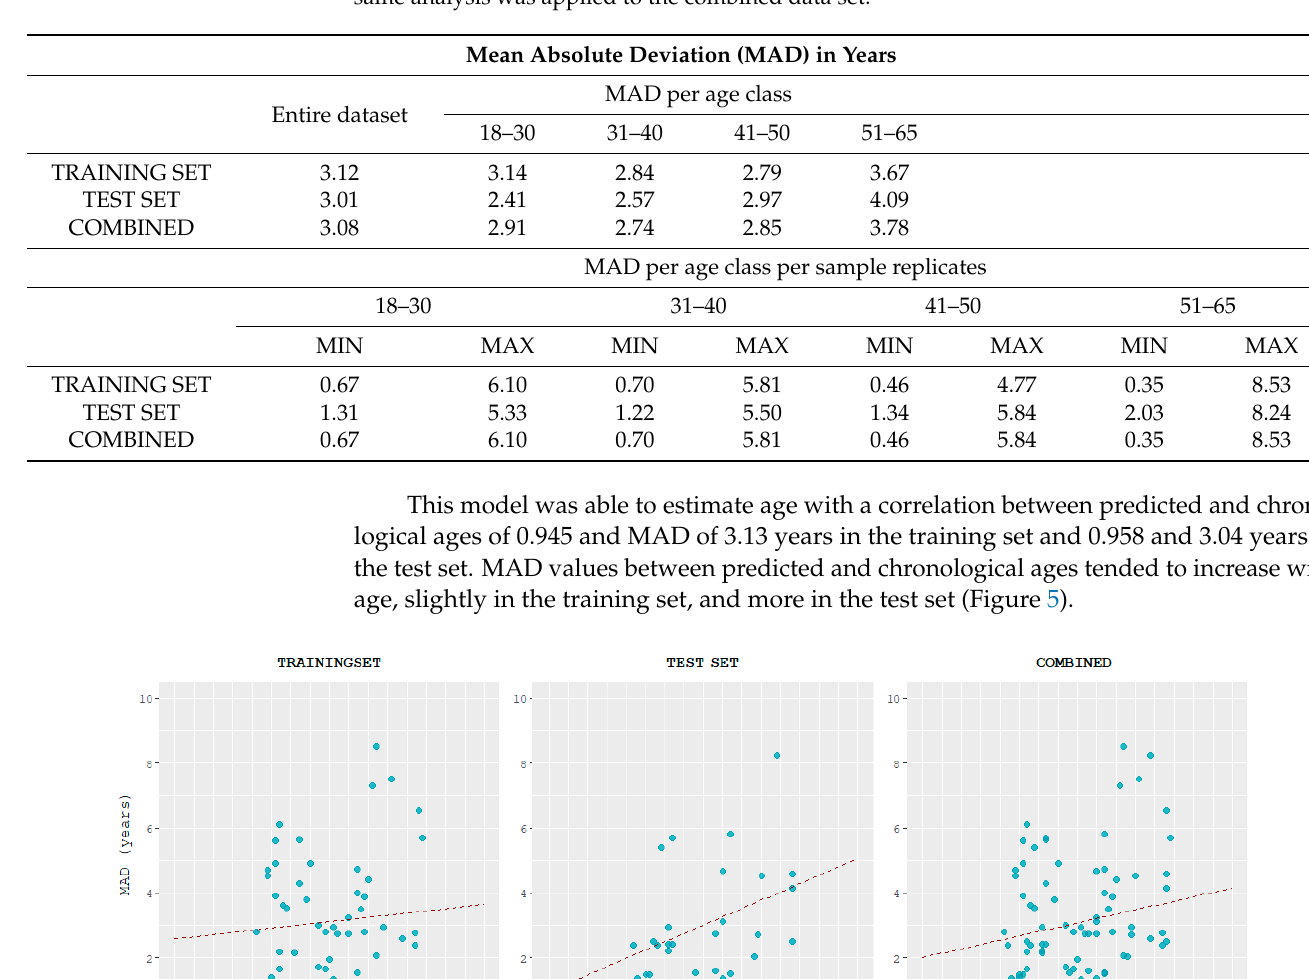
Table 2. Mean Absolute Deviation (years) values calculated for both datasets separately in their en- tirety and after dividing the samples into age classes (top rows). MAD was also calculated consid- ering the sample replicates as a group and according to their age class (bo tt om rows). The same analysis was applied to the combined data set.